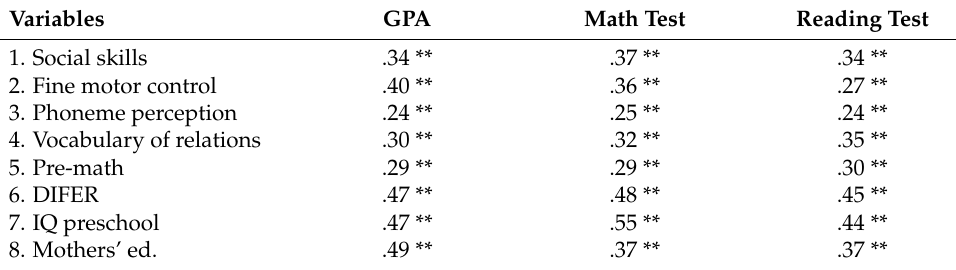
Table 4. Correlations of the Independent and Dependent Variables.